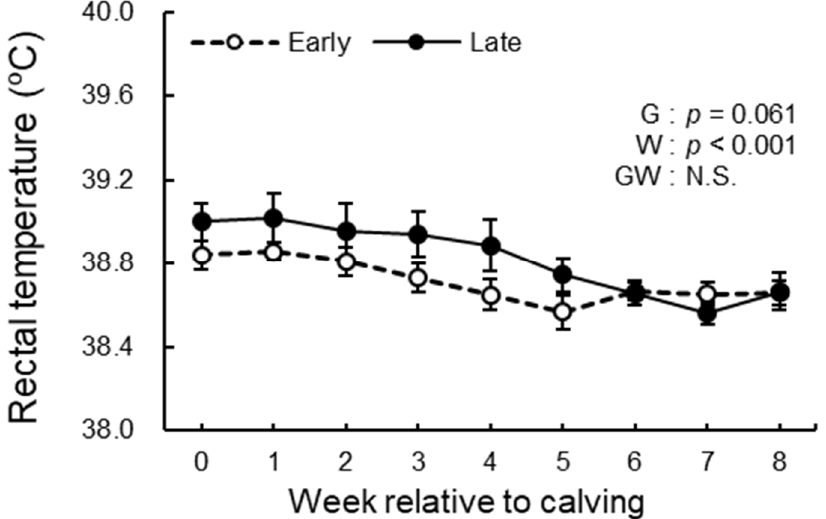
Figure 6. Rectal temperature from −4 to 8 wk relative to calving for cows classified into the early group (Early) and the late group (Late). Early = cows with endometrial inflammation converged within 4 wk, n = 17; Late = cows with endometrial inflammation converged at or after 5 wk, n = 16. The week of calving is defined as 0 wk. G = group effect; W = week effect; GW = group-by-week